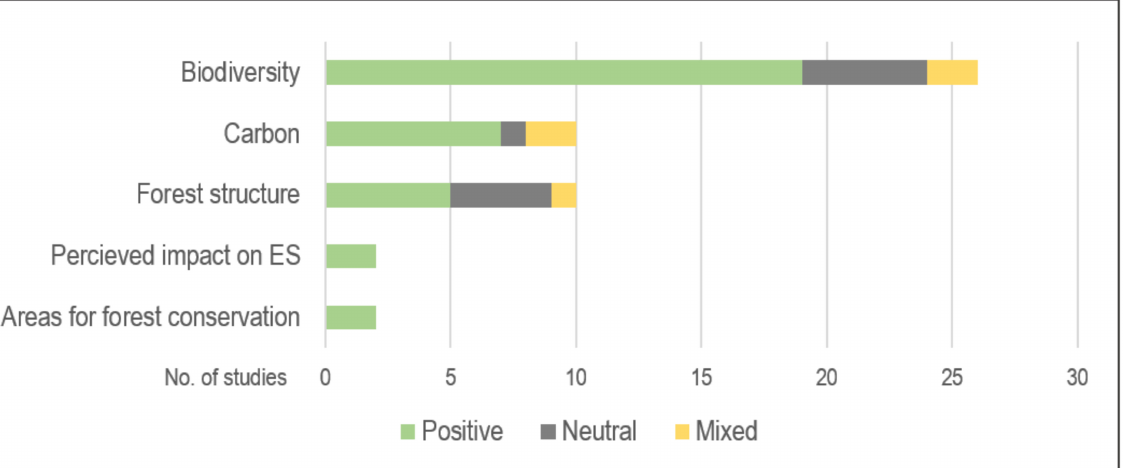
Figure 6. Impact of forest certification on forest degradation. Presented by indicator and number of case studies.